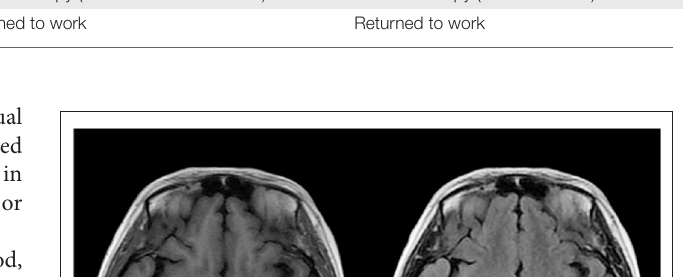
with dosage decreasing and discharged with oral